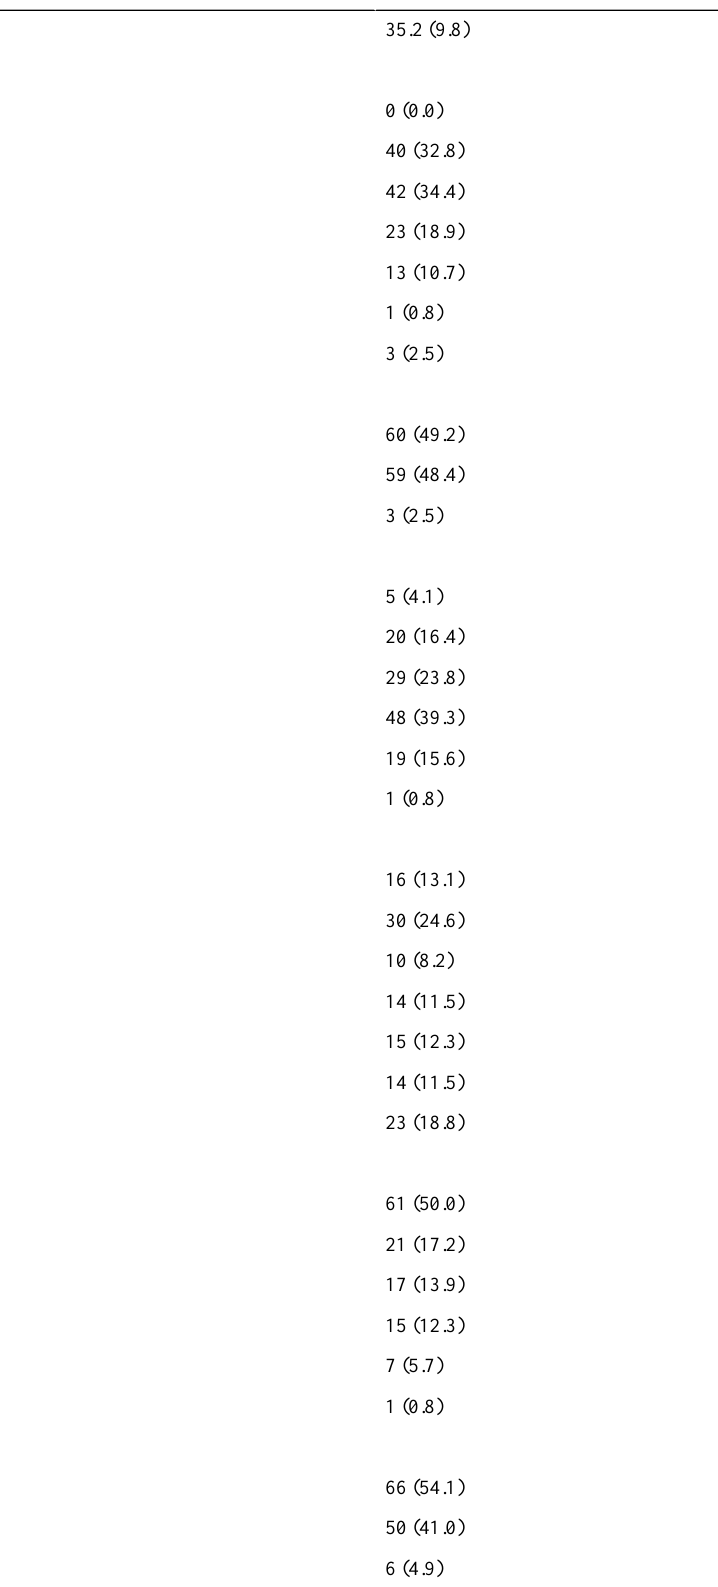
Table 2. Demographics of the subjects in the study (N=121).